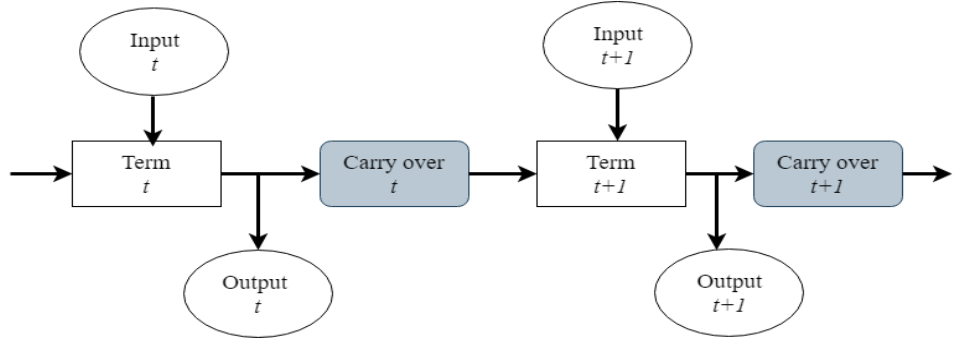
Figure 1. The dynamic structure of the production technology in consecutive period t .